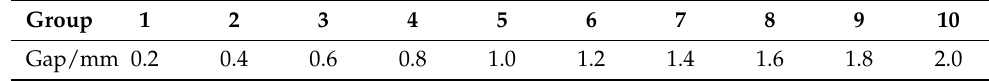
Table 2. Guide bar and guide hole clearance configuration.